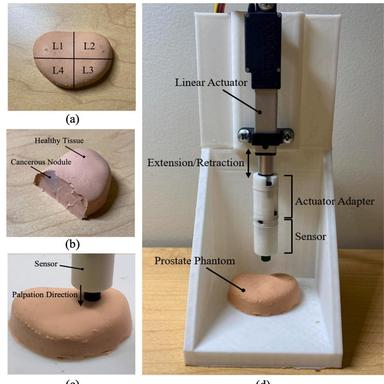
(a) Prostate phantom with labelled quadrants for compression experiments. Cancerous nodules are located in L1. (b) Cross-section of the prostate phantom with the cancerous nodule. (c) Schematic diagram showing indentation direction to indent the tissue by 5 mm. (d) Test rig with actuator/sensor assembly for testing. The linear actuator retracts and extends the sensor to palpate the tissue as seen in (c).